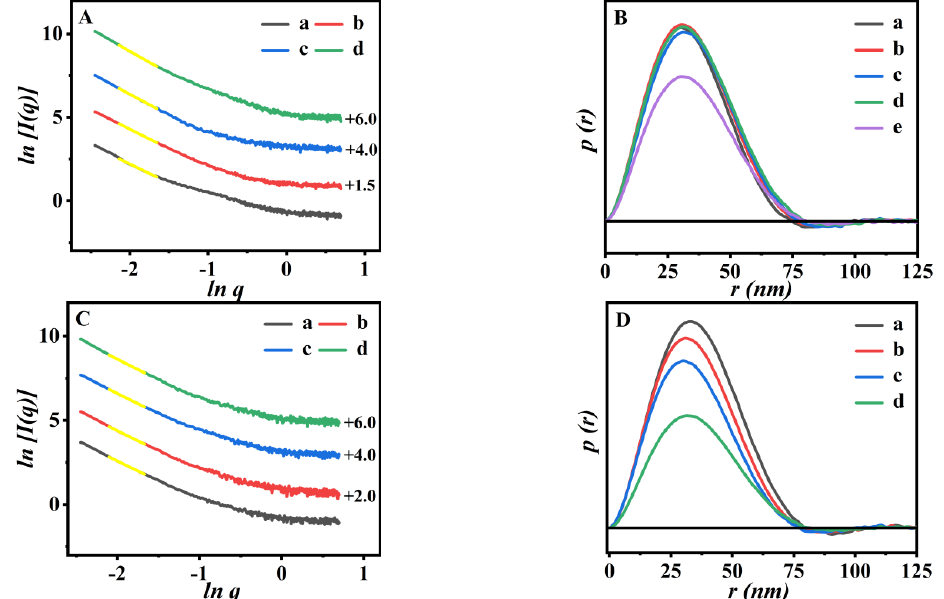
Figure 4. Shifted scattering curves ( A ) with their fractal values (insert), and PDDF profiles ( B ) of (a) PAA, (b) P(NA- AA)−0−0.1 , (c) P(NA- AA)−0−1 , and (e) P(NA- AA)−0−1 0. Shifted scattering patterns ( C ) with their fractal values (insert), and PDDF profiles ( D ) of (a) P(NA- AA)−0−0.1 , (b) P(NA- AA)−1−0.1 , (c) P(NA-AA)-3-0.1, and (d) P(NA- AA)−7−0.1 . Notes: (1) the linear ranges in Figure 4A,C with a higher coefficient ( R 2 ˃ 0.99) were − 2.10 < ln q < − 1.67. (2) Figure 4A,C shows the offset values on the right y -axis.